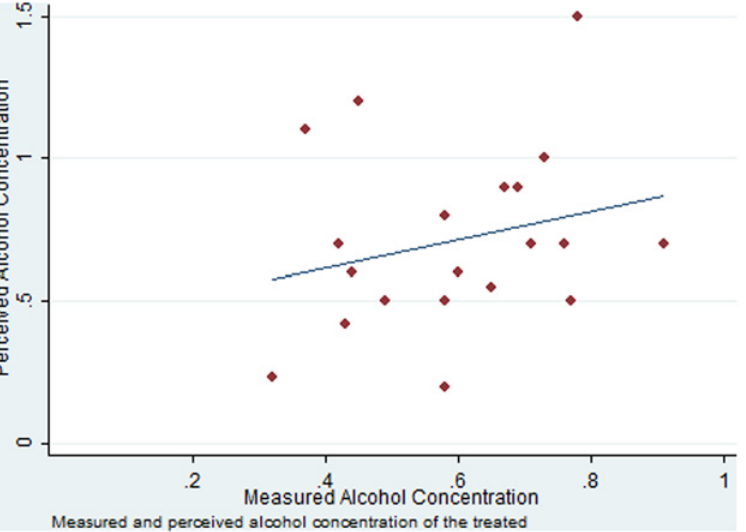
Fig 2. Measured and Perceived Alcohol Concentration of the